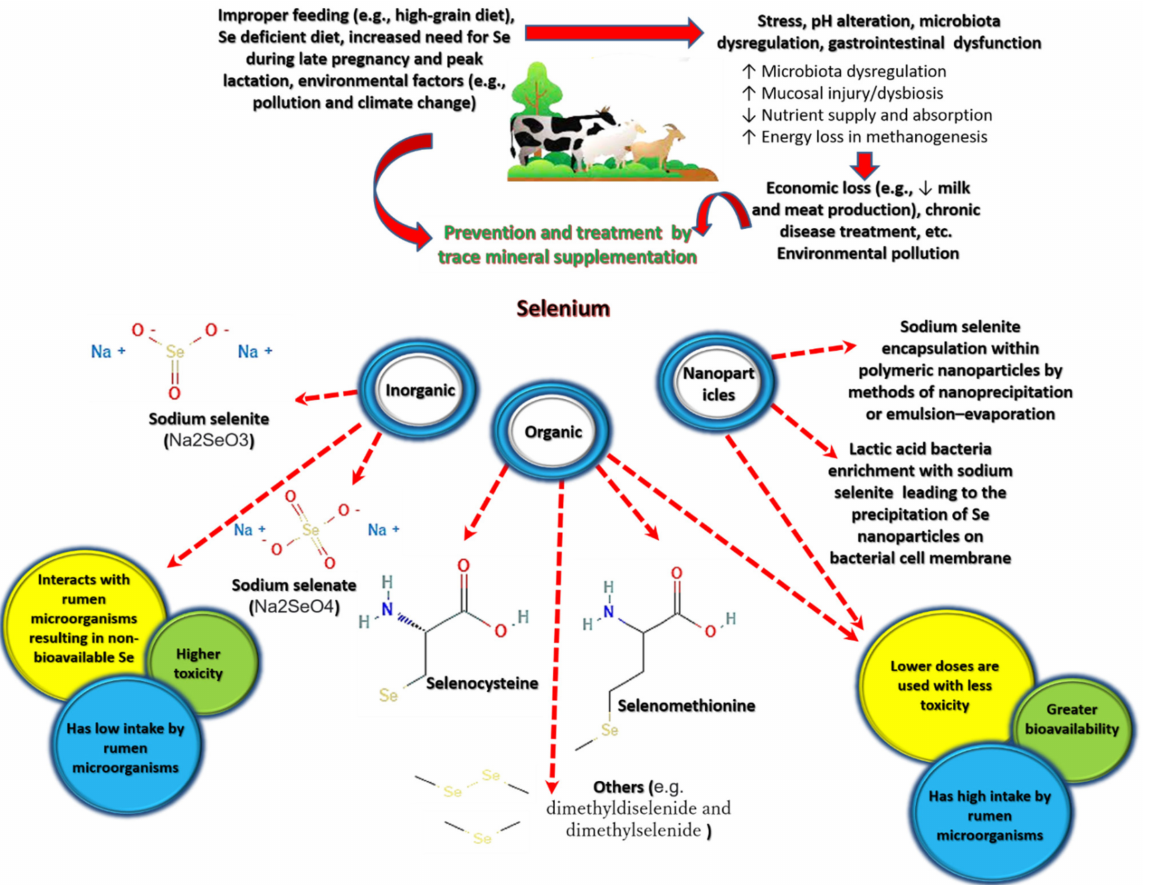
Figure 1. Schematic illustration of possible causes of altered fermentation in ruminants and possible treatment with selenium (Se). Se deficiency can largely affect farm animals, even before they are born. This is because of increased maternal need for Se during the third trimester of pregnancy and during peak lactation. Increased Se supply is needed to promote muscular growth in bovine fetus and growing calves, and lack of Se supplementation during these two stages may evoke diseases associated with Se deficiency in bovine neonates and nursing calves (e.g., white meat disease). Several factors such as high grain diets, mineral deficiency, and stress inflected by climate change negatively affect fermentation through interference with ruminal pH and ruminal microbiota structure/activity. Poor digestibility and deficient fermentation result in excessive energy loss and decreased yield of energetic value, leading to environmental pollution and less milk and meat production. Trace